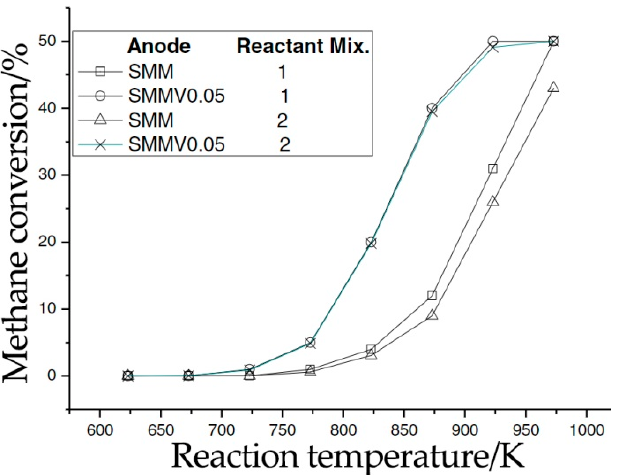
Figure 10. Temperature dependence of the conversion degree of biogas in the case of using Sr 2 MgMoO 6– δ (SMM) or Sr 2 MgMo 0.95 V 0.05 O 6– δ (SMMV0.05): 1–6% CH 4 , 6% O 2 , 4% CO 2 , 84 % N 2 ; 2–6% CH 4 , 6% O 2 , 4% CO 2 , 83 % N 2 , 1% H 2 S. Reproduced with permission [45]. Copyright 2015, Elsevier.